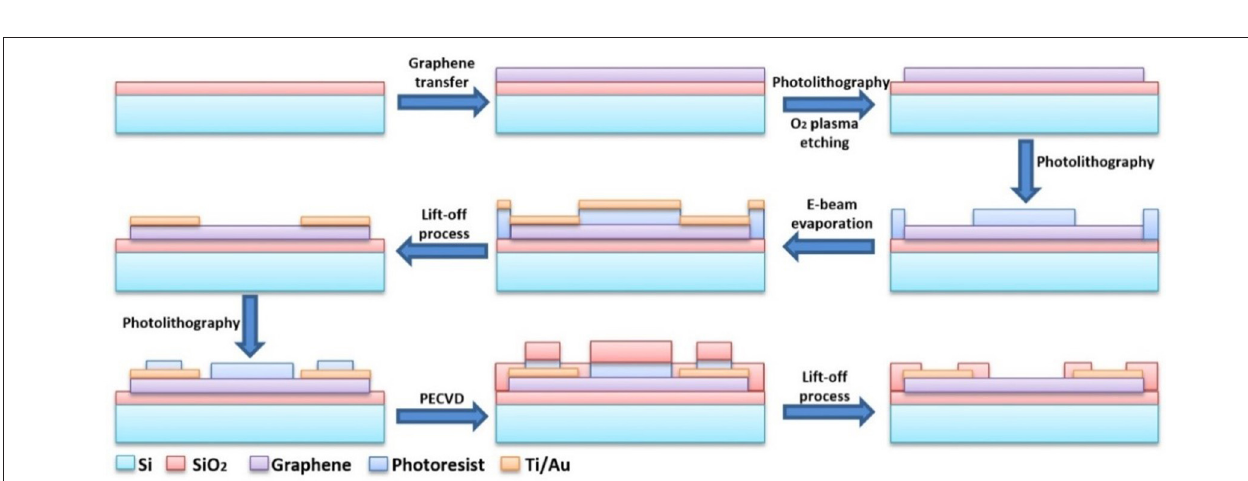
FIGURE 2 | The schematic graphs of the fabrication process flow of the GFET